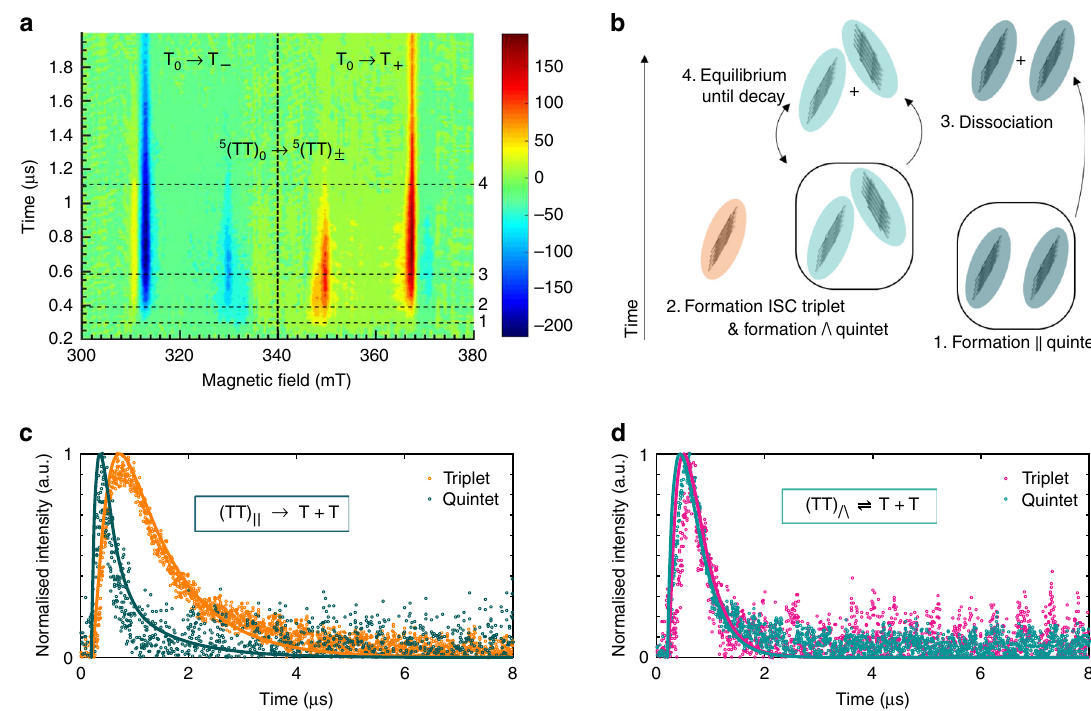
Fig. 7 Dynamics of the triplet and quintet states. a Tr-EPR of the 10% pentacene in p -terphenyl 1 μ m fi lm. The innermost peaks from the centre- fi eld belong to strongly coupled triplets from parallel dimers, 5 (TT) || , with the next pair of peaks originating from strongly coupled triplets with a herringbone geometry, 5 (TT) //. The penultimate and strongest pair of peaks belong to dissociated parallel triplets and isolated ISC crossing triplets, (T). The outermost peaks are the dissociated triplets from the herringbone quintet. Timescales for the formation and dissociation of spin species are labelled 1 – 4 on the right-hand side. b Schematic of the triplet and quintet kinetics: (i) formation of 5 (TT) || , (ii) formation of ISC (T) and of the 5 (TT) /\ , (iii) dissociation of the quintets into triplets, (iv) equilibrium state between ð TT Þ = n " T þ T , forming a trap-state, whilst (TT) || → T + T forms long-lived triplets. c , d Show the experimental (circles) and modelled (line) time traces of the parallel and herringbone geometries, respectively. Experimental traces in emission have been inverted for